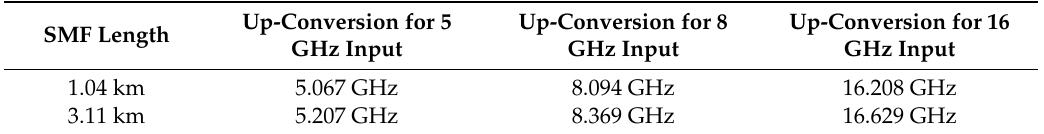
Table 2. The tunability of the up-conversion system for the 5 GHz, 8 GHz and 16 GHZ input signals in experiment.